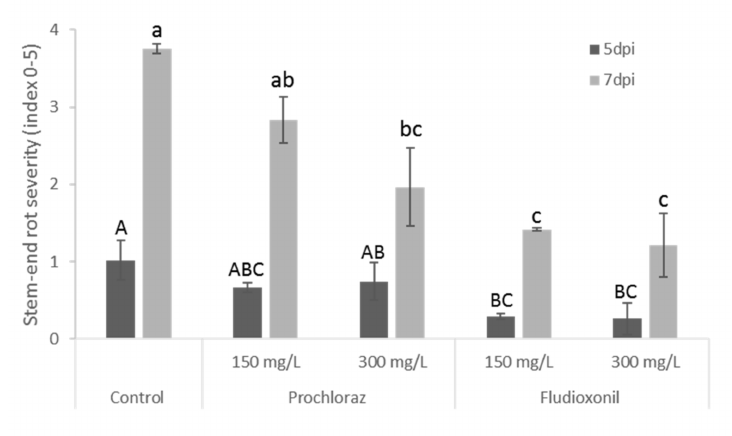
Figure 1. Postharvest fungicide application on “Pinkerton” avocado fruit inoculated with Lasiodiplodia theobromae . Stem-end rot severity caused by L. theobromae (index 1–10) after 5 and 7 days post-inoculation (dpi). Presented values are average and standard error. Di ff erent letters indicate a significant di ff erence ( p < 0.05) by one-way ANOVA at each time